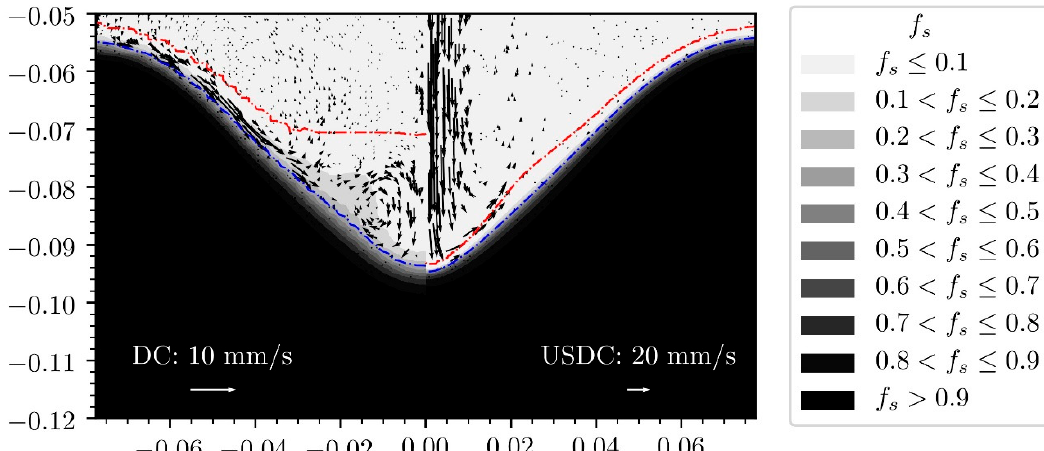
Figure 4. Comparison of sump profiles between conventional DC casting (left) and ultrasonic-assisted DC casting (right). f s is the solid fraction using the casting conditions defined in [38]. Arrows are shown for the scale of the velocity field. The red dash-dotted line represents the liquidus temperature and the blue dash-dotted line denotes the coherency temperature (solid packing fraction). The dataset used to reproduce these results is available elsewhere [73].